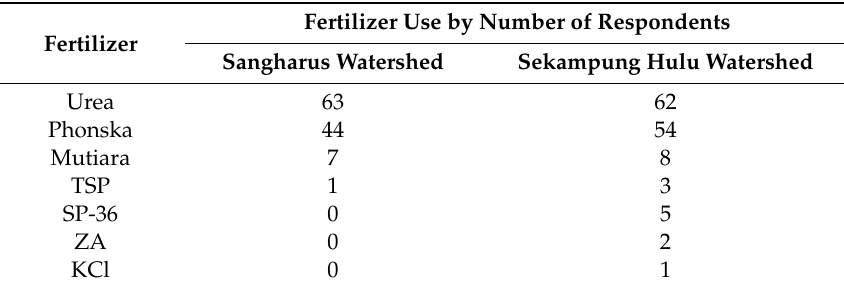
Table 3. Types and number of fertilizers applied in the watersheds. Fertilizer Use by Number of Respondents Fertilizer